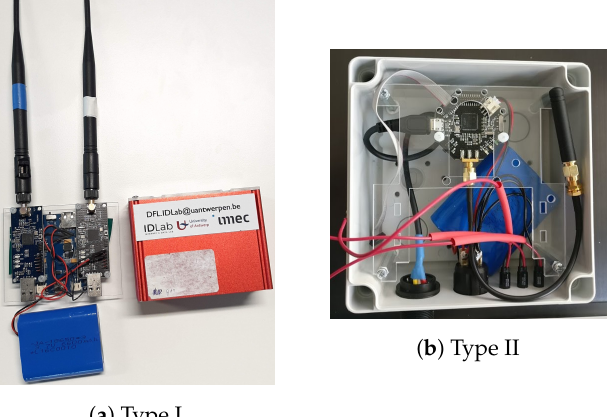
Figure 1. The two node types used for the experimental measurements. ( a ) shows an image of the main parts of which a Type I node consists and ( b ) shows an image of the inside of a Type II node variant containing only an 868 MHz